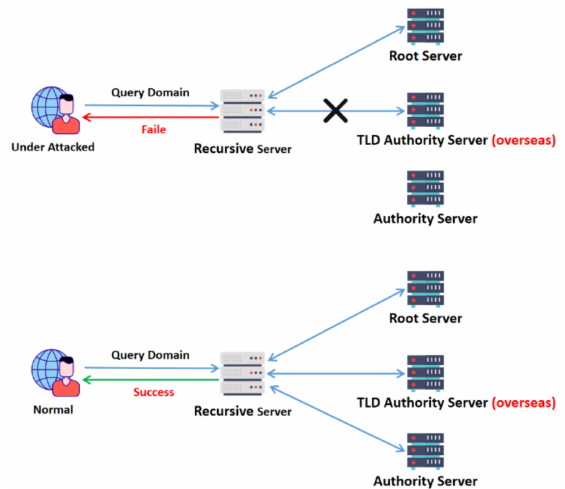
Figure 3. E ff ects of isolated